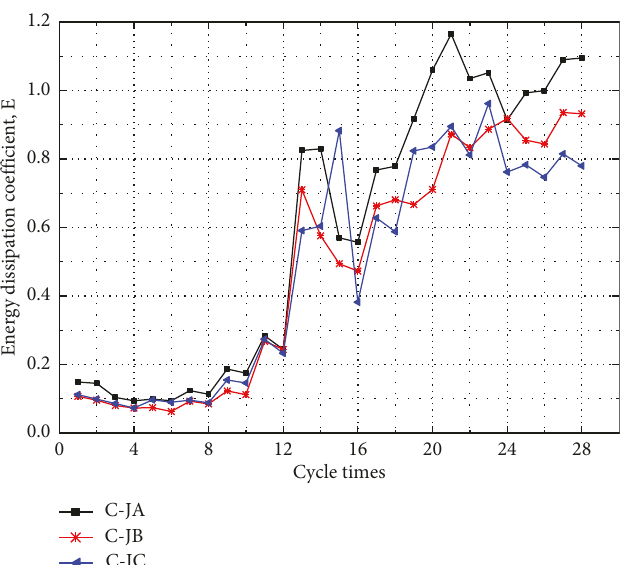
Figure 10: Comparison of the energy dissipation coefficient.